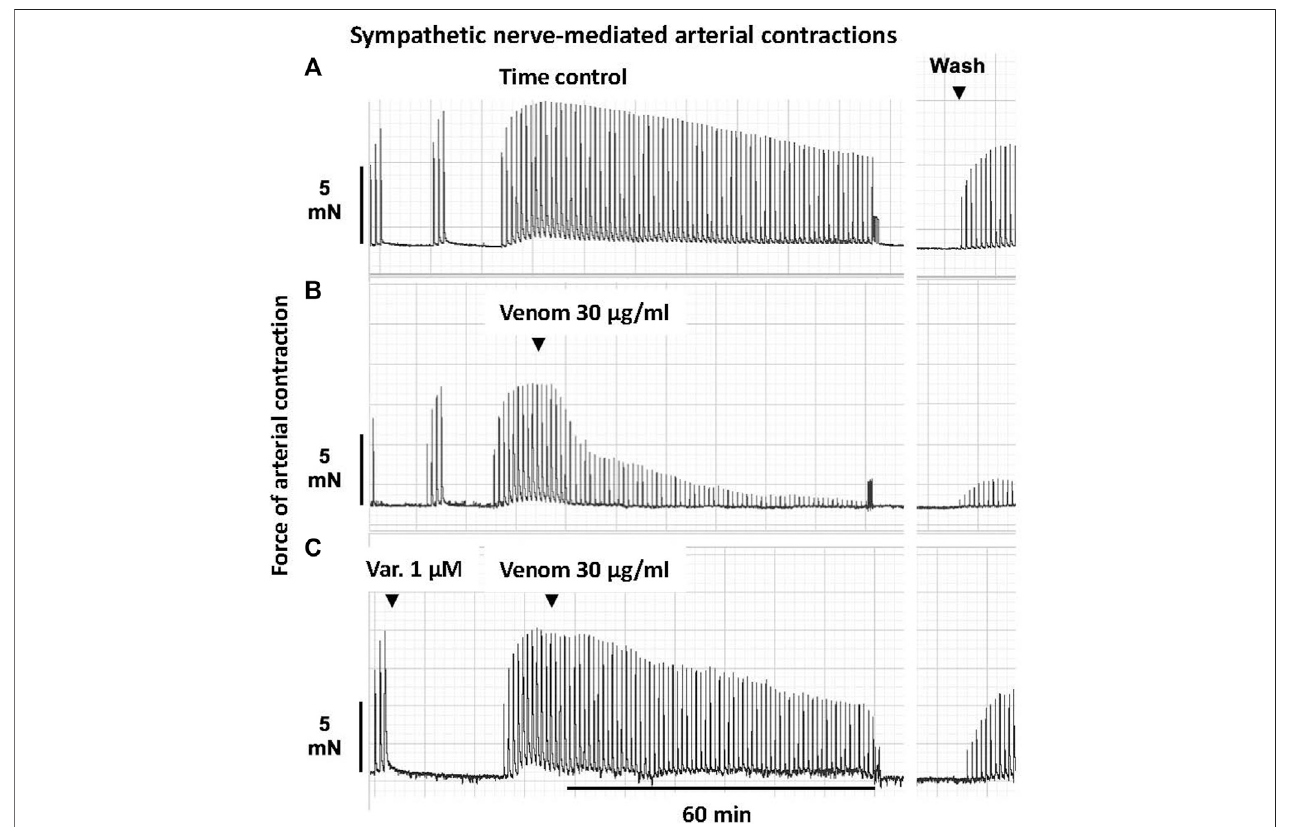
FIGURE1| Representativecomputertracesofthesympatholyticeffectsof Pseudonajaaf fi nis venomintheabsenceorpresenceofthesPLA 2 inhibitorvarespladib in rat isolated electrically stimulated small mesenteric arteries. (A) Time control – no venom or inhibitor treatment. (B) The addition of P. af fi nis venom (30 µg/ml) markedly inhibited nerve-mediated contractions (C) Pre-incubation with varespladib 1 µM (Var.) attenuated the sympatholytic effects of P. af fi nis venom. Wash, after 30 min of repeatedwashoutofthebathsolution,nervestimulationresponseswereretested;verylittlerecoveryofcontractileresponseswasobservedaftervenomtreatment alone (B)